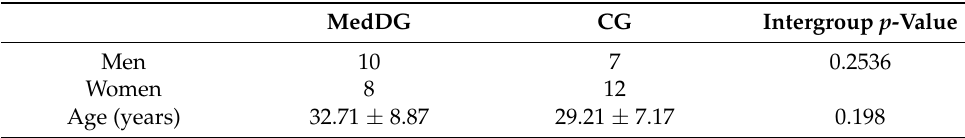
Figure 2. CONSORT flow diagram, modified according to [13], 24dr = 24-h dietary recall, FFQ = food Original Figure 4: frequency questionnaire, MEDAS = Mediterranean Diet Adherence Screener. Table 1. Baseline characteristics of MedDG and CG.